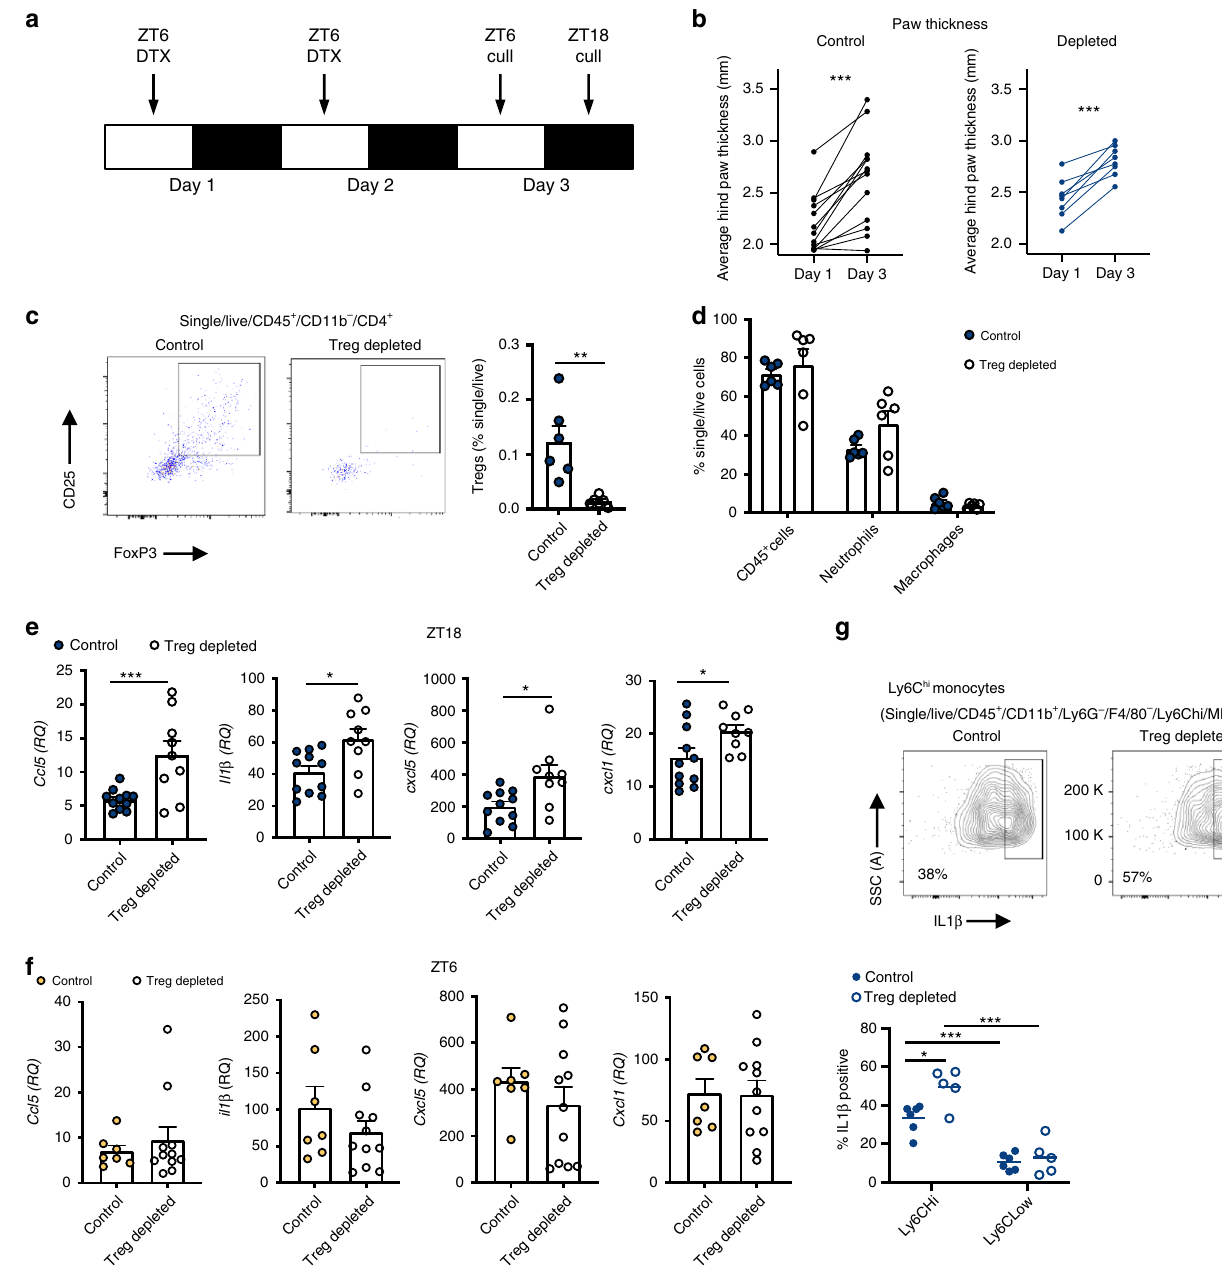
Fig. 5 Depletion of Treg cells increases localised proin fl ammatory cytokine expression. a Two daily injections of DTX at ZT6 led to signi fi cant depletion of Tregs 24 – 36 h after the last injection. b Progression of arthritis (as assessed by hind paw swelling) in control mice ( n = 13) and in mice with depleted Tregs ( n = 8), two-sided paired T tests. c Quanti fi cation of Tregs in arthritic control ( n = 6) and Treg depleted ( n = 6) animals, two-sided unpaired T -tests. Data are presented as mean values ± SEM. d Quanti fi cation of in fl ammatory cell populations within the in fl amed joints in arthritic control ( n = 6) and Treg- depleted mice ( n = 6), one-way ANOVA. Data are presented as mean values ± SEM. e QPCR analysis of in fl ammatory genes (normalised to gapdh ) within the joints of arthritic control ( n = 11) and Treg-depleted ( n = 9) mice culled at ZT18. Values were normalised to expression in control animals without arthritis, two-sided unpaired t tests. Data are presented as mean values ± SEM. f QPCR analysis of in fl ammatory genes (normalised to gapdh ) within the joints of arthritic control ( n = 7) and Treg-depleted ( n = 11) mice culled at ZT6. Values were normalised to expression in control animals without arthritis. Data are presented as mean values ± SEM. g Effect of depletion of Tregs on IL-1 β expression by joint monocytes (control n = 6; Treg depleted n = 5), two- way ANOVA and post hoc Bonferonni. Graph shows individual data points and mean values. In all panels statistical signi fi cance is shown as * p < 0.05, ** p < 0.01 and *** p < 0.005. Source data are provided as a Source Data fi